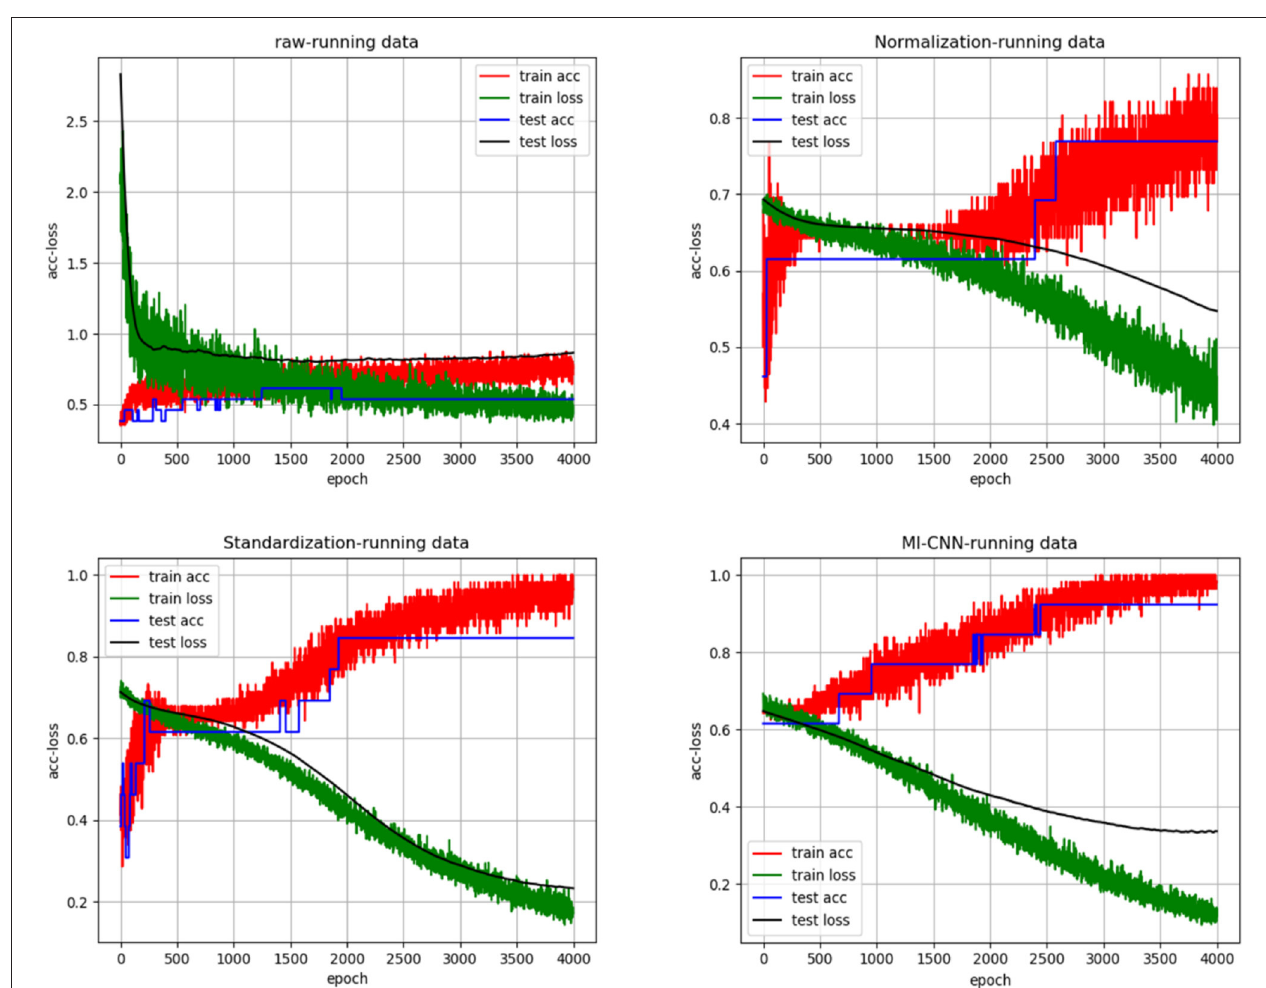
FIGURE 5 | “acc-loss” curves with different data preprocessing on the running dataset.